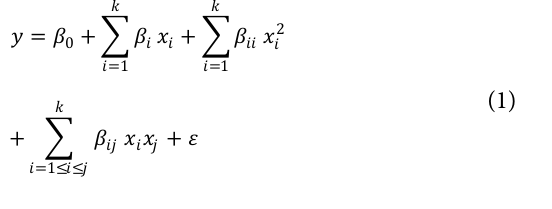
Fig. 1. MPA-capped CuInS